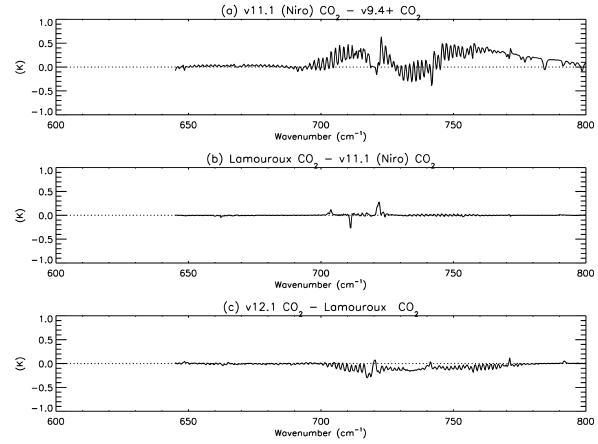
Fig. 4. Differences of the modeled brightness temperature spectrum (moderate water vapor case) in the CO 2 ν 2 band due to changes in CO 2 spectroscopy. All results are for the moderate water vapor case. (a) LBLRTM v11.1 CO 2 (which includes the Niro et al. (2005) P-, Q-, and R-branch line coupling parameters) minus v9.4 + . (b) Lam- ouroux et al. (2010) line coupling parameters (based on HITRAN 2008) minus Niro et al. (2005) (based on HITRAN 2004). (c) v12.1 CO 2 parameters (with CDSD position and strengths) minus Lam- ouroux et al.